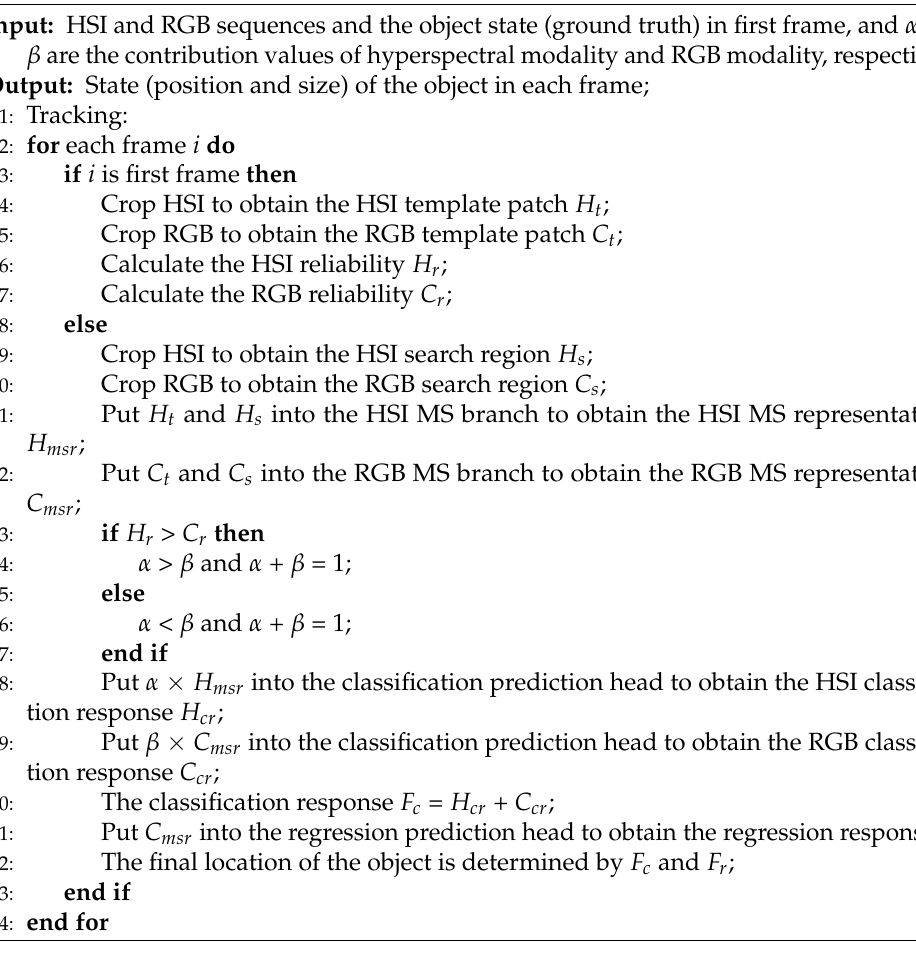
Figure 2. The RANet network architecture. CH represents the classification prediction head and RH represents the regression prediction head. In addition, α and β represent the predicted contribution of HSI and RGB, respectively, and the symbol ⊕ represents the merge operation. The object’s final position is determined by the classification and the regression responses. Algorithm 1 Reliability-guided Aggregation Network